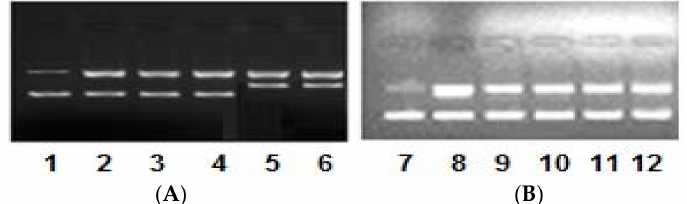
Figure 5. Electrophoretic pattern of pBR322 DNA (100 ng) by ( A ) complex 1 and ( B ) complex 2 (0.5–2.5 µ M) in 50 mM Tris-HCl/NaCl buffer pH, 7.4 after 45 min of incubation at various concentrations. Lane 1: DNA alone (control); Lane 2: DNA + 0.5 µ M 1 ; Lane 3: DNA + 1.0 µ M 1 ; Lane 4: DNA + 1.5 µ M 1 ; Lane 5: DNA + 2.0 µ M 1 ; Lane 6: DNA + 2.5 µ M 1 ; Lane 7: DNA alone (control); Lane 8: DNA + 0.5 µ M 2 ; Lane 9: DNA + 1.0 µ M 2 ; Lane 10: DNA + 1.5 µ M 2 ; Lane 11: DNA + 2.0 µ M 2 ; Lane 12: DNA + 2.5 µ M 2